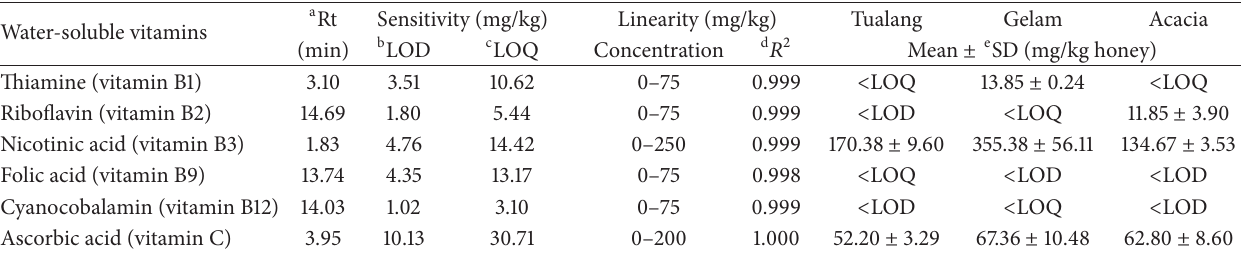
Table 2: Water-soluble vitamins in honey